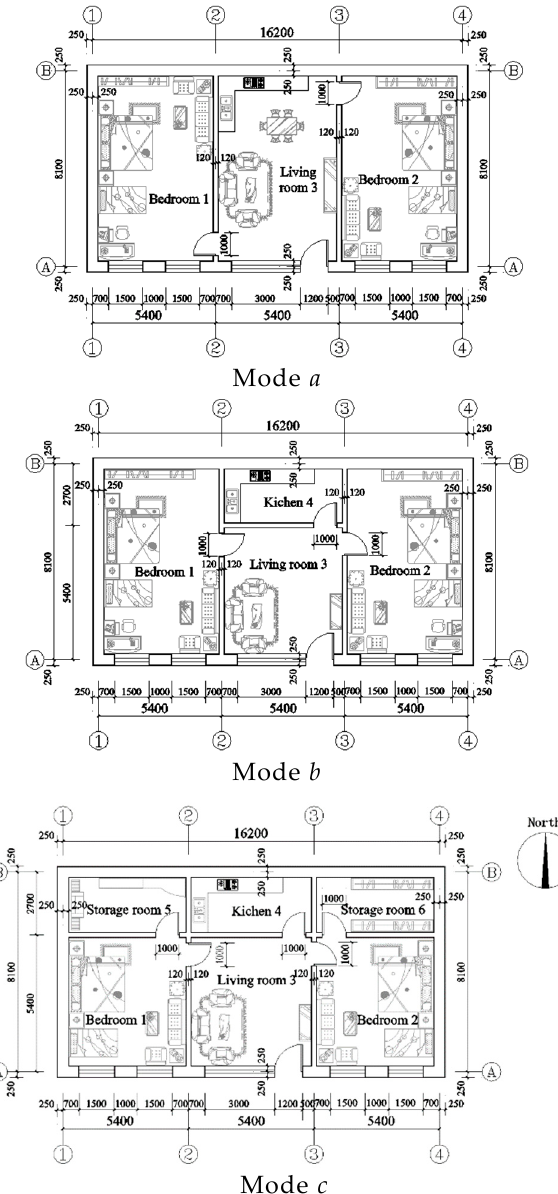
Figure 8. Three indoor space-arrangement modes. Table 2. Parameters of space-arrangement modes.